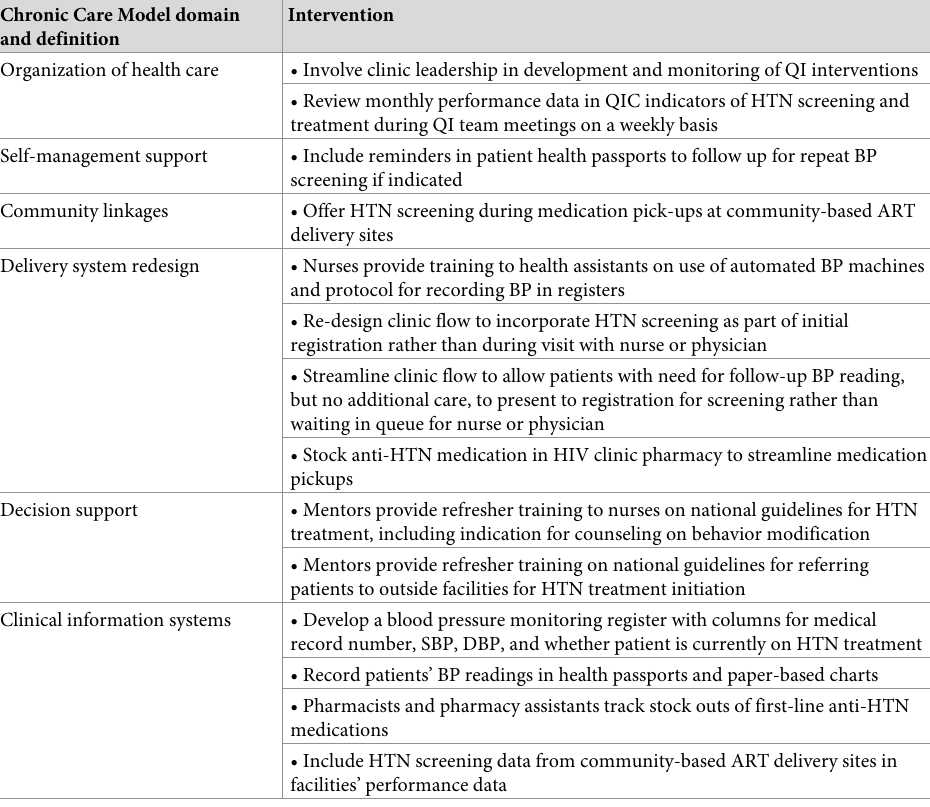
Table 2. Implemented change ideas by Chronic Care Model